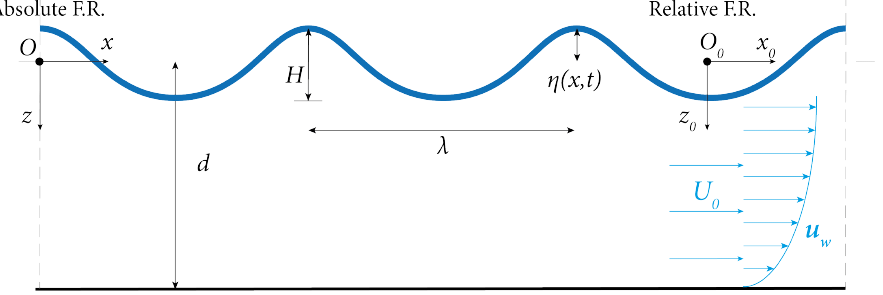
Figure 2. Absolute and relative reference systems to describe wave propagation over a steady